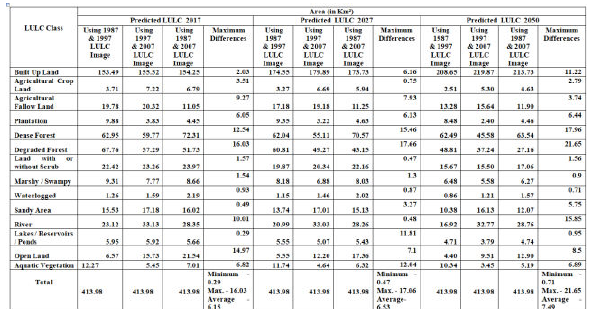
Table 4. Area statistics of predicted LULC of 2017, 2027,